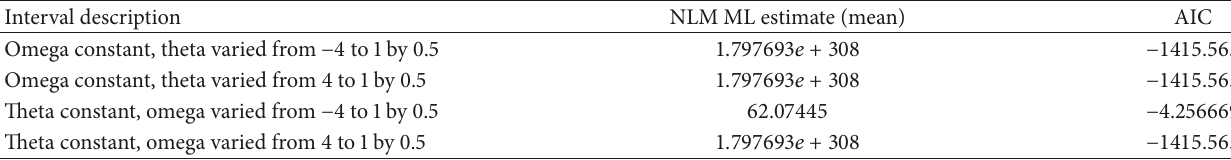
Table 1: Summary of results for lambda = 0.1.